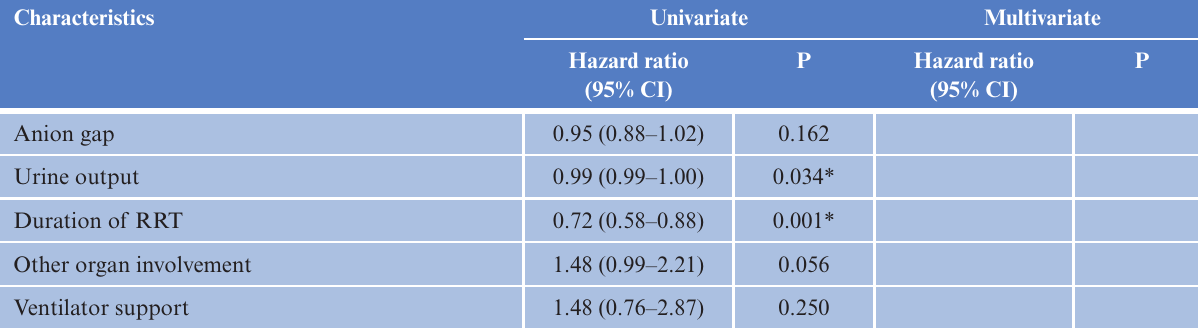
A few markers of inflammation and the evaluation of degree of lung damage could not be assessed completely in all patients. None of the survivors with nonrenal recovery underwent a renal